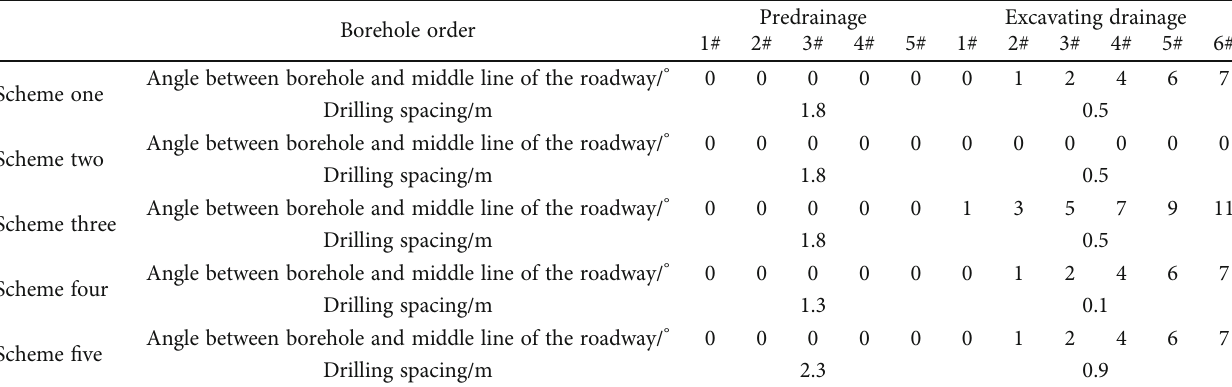
Table 2: Drilling layout parameters of di ff erent